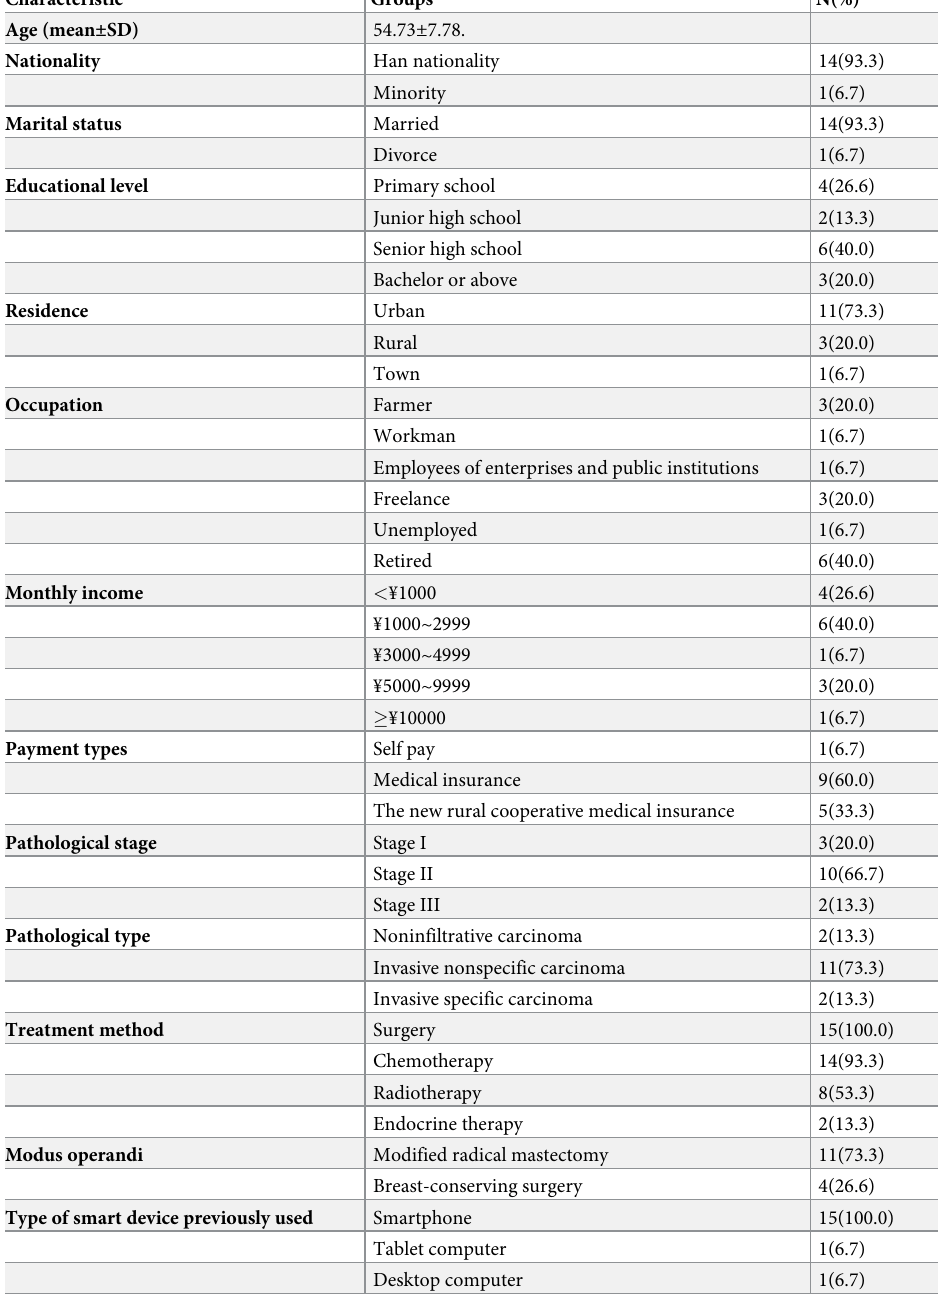
Table 3. General demographic information (N =